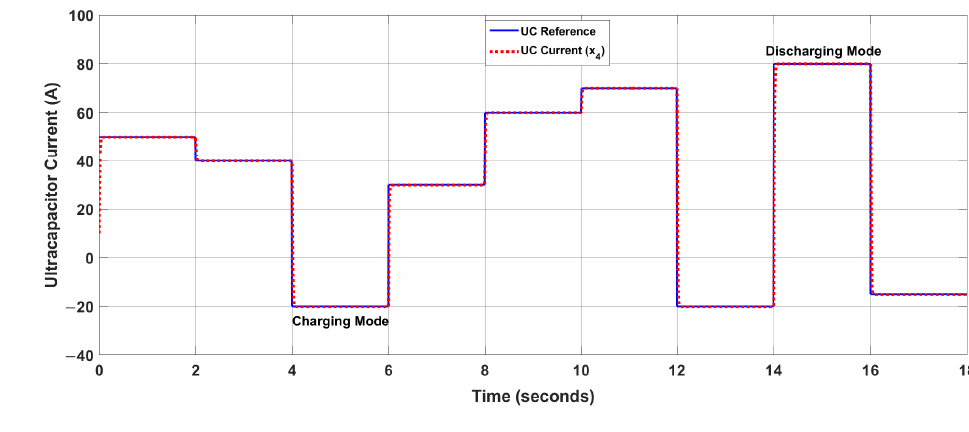
Figure 11. UC current x 4